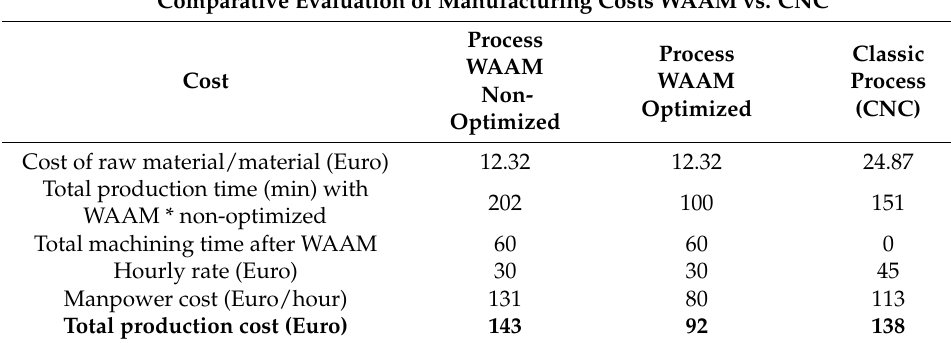
Table 7. Comparison of WAAM-CNC component manufacturing costs.